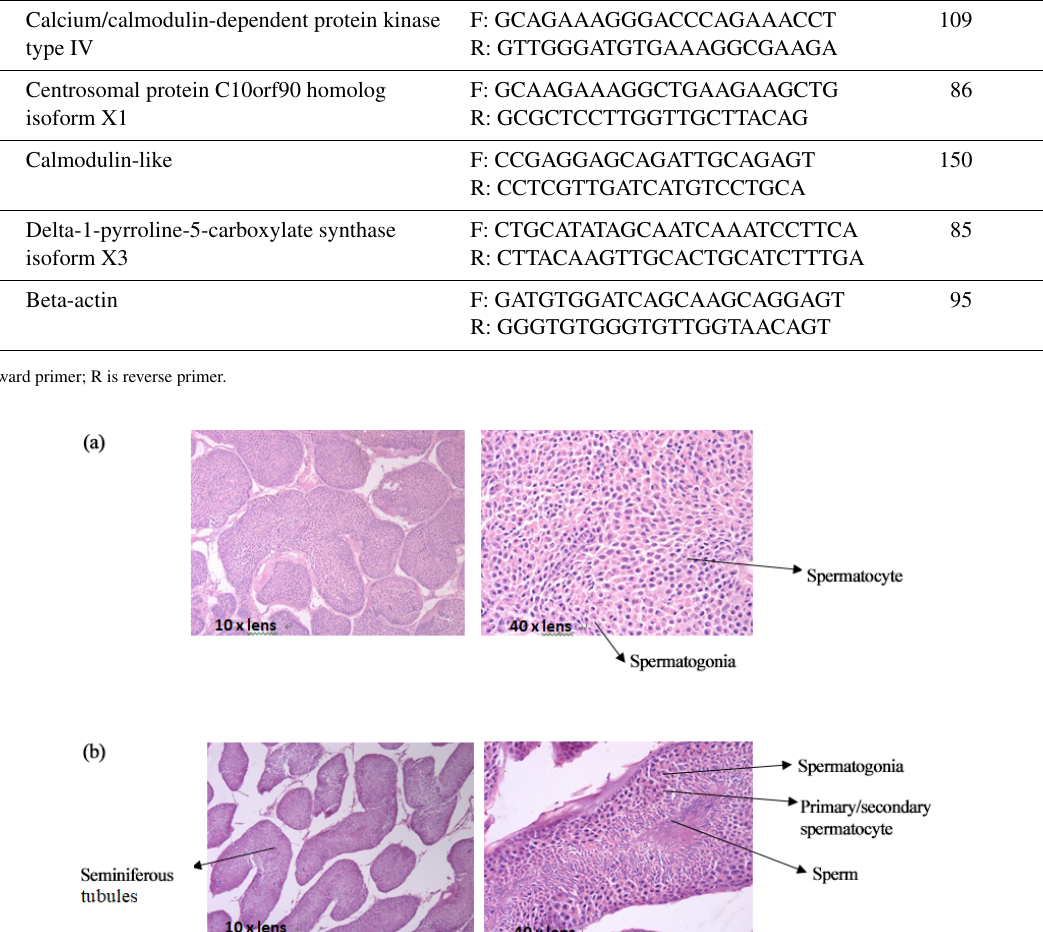
argininosuccinate synthase, delta-1-pyrroline-5-carboxylate synthetase ALDH18A1 (P5CS) and proline dehydrogenase (PRODH). Genes more highly expressed in the Pekin